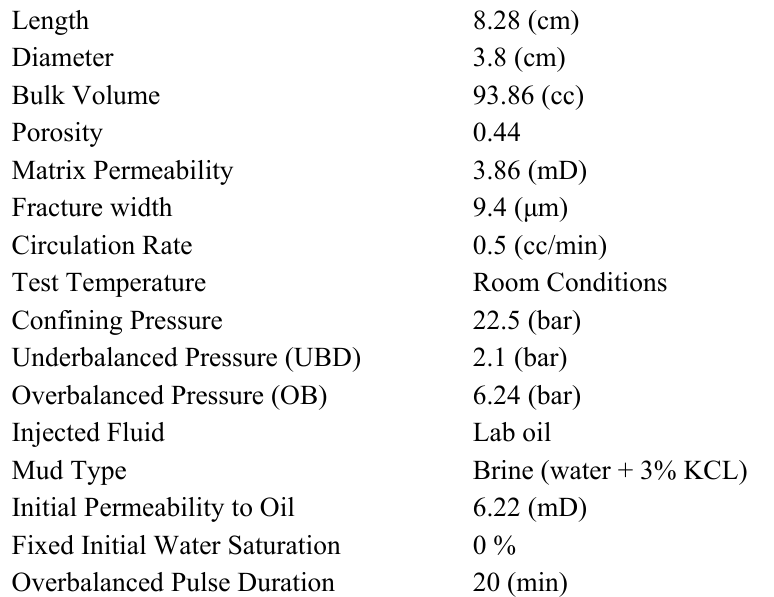
Table 4. UBD leak-off test with brine; Sample